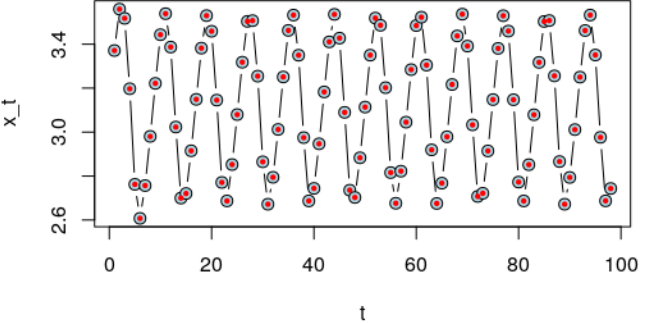
Figure 5. Observations in blue, approximation in red (smaller circle). Please observe how each approximation lays over the actual